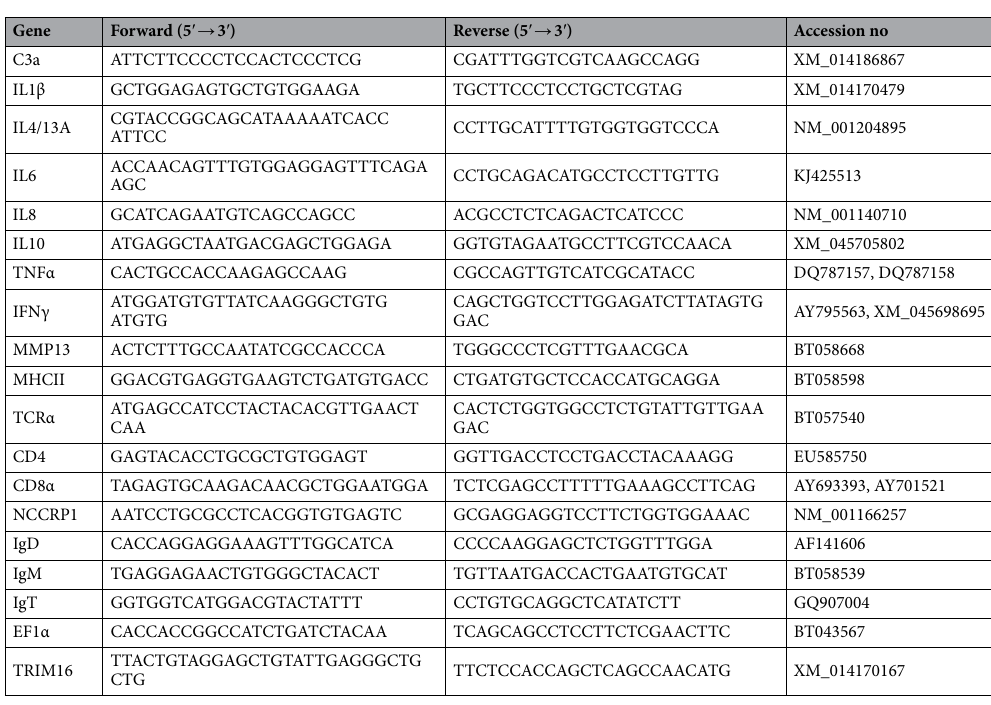
Table 2. Sequences of primers used for real time RT-PCR analyzing immune responses in Atlantic salmon. Gene name abbreviations: complement component (C), interleukin (IL), tumor necrosis factor (TNF), interferon (IFN), matrix metalloproteinase (MMP), major histocompatibility complex (MHC), T-cell receptor (TCR), cluster of differentiation (CD), non-specific cytotoxic cell receptor (NCCR), immunoglobulin (Ig), elongation factor (EF), and tripartite motif-containing (TRIM)